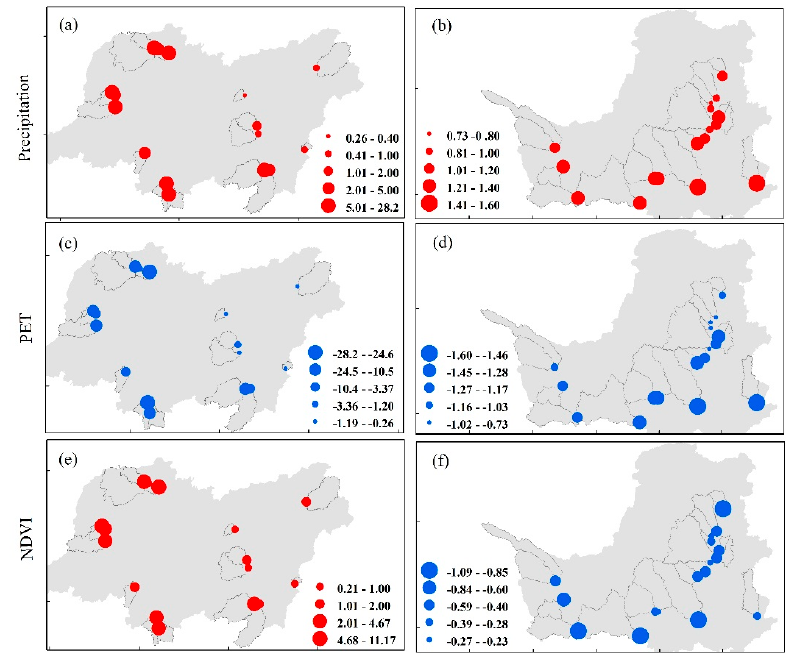
Figure 4. Spatial distribution of the sensitivity of WER to precipitation, PET and NDVI. The left column, from ( a – e ), represents the energy-limited condition, and the right column, from ( b – f ), represents the water-limited condition.